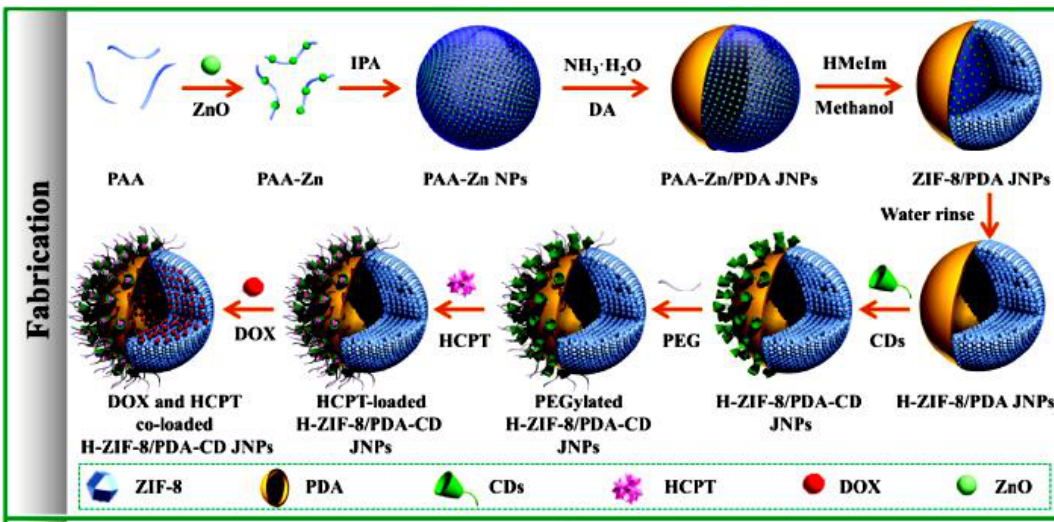
Figure 4. Schematic illustration of fabricating the H-ZIF-8 / PDA-CD JNPs. The starting synthetic materials are poly(acrylic acid) (PAA), isopropyl alcohol (IPA), 2-methylimidazole (HMeIm) and dopamine (DA). The PEG was later employed for improving the stability of JNPs. Reproduced from Reference [28] with permission from Elsevier B. V. Copyright 2019.